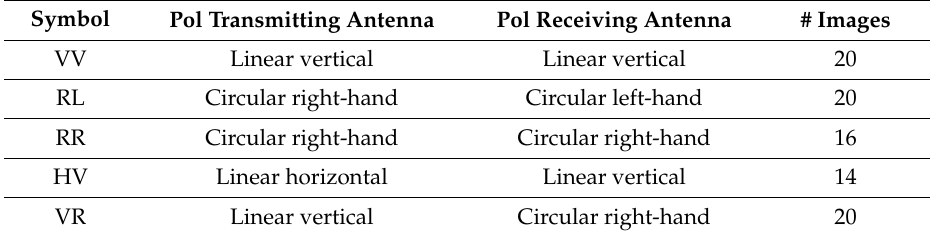
Table 4. Configurations of the short time